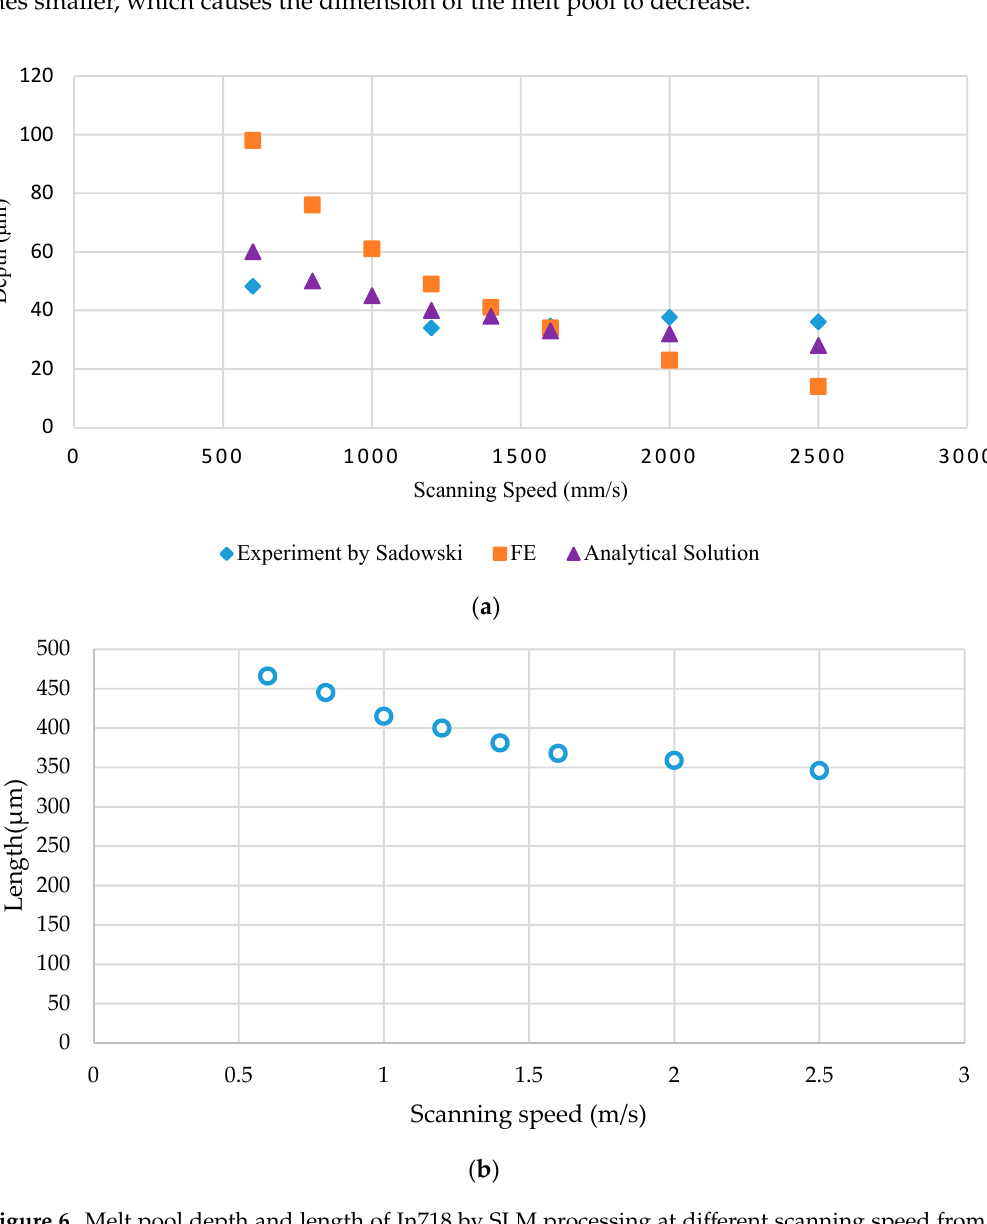
Figure 6. Melt pool depth and length of In718 by SLM processing at different scanning speed from experiment, FE modeling and analytical solution (laser power is 200 W). ( a ) Depth of melt pool, ( b ) length of melt pool.